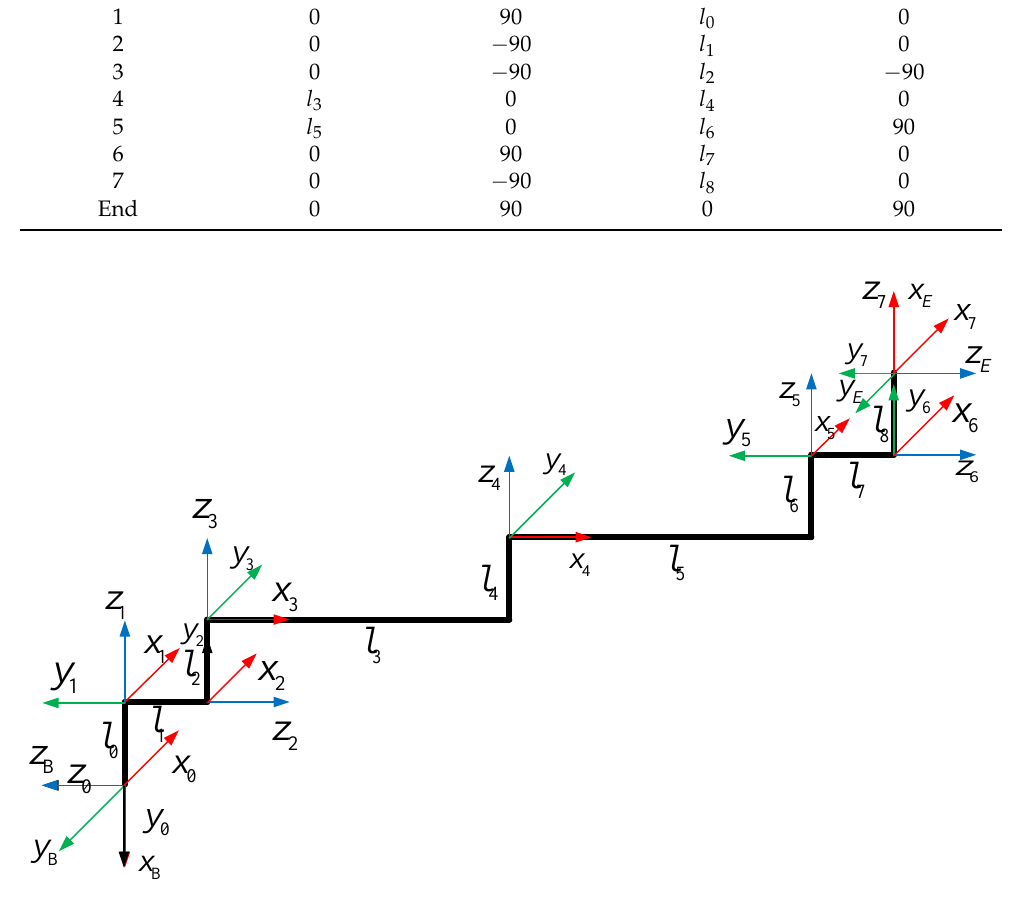
Figure 7. The D-H Frame of the CMM/EMM. Table 2. Joint properties of the CMM and